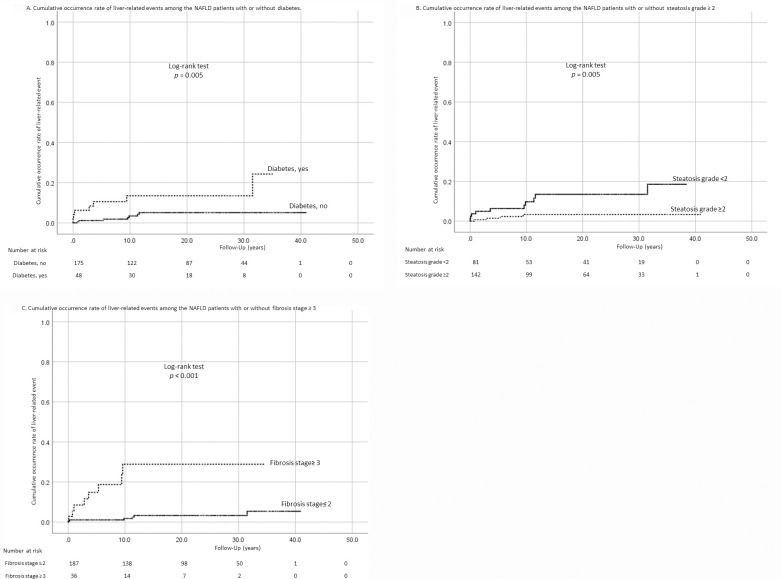
Cumulative occurrence rate of liver-related events.(A) Cumulative occurrence rate of liver-related events in patients with nonalcoholic fatty liver disease (NAFLD) with and without type 2 diabetes mellitus. (B) Cumulative occurrence rate of liver-related events in NALFD patients with grade <2 steatosis and those with grade ≥2 steatosis. (C) Cumulative occurrence rate of liver-related events in NALFD patients with stage ≤2 fibrosis and in those with stage ≥3 fibrosis.